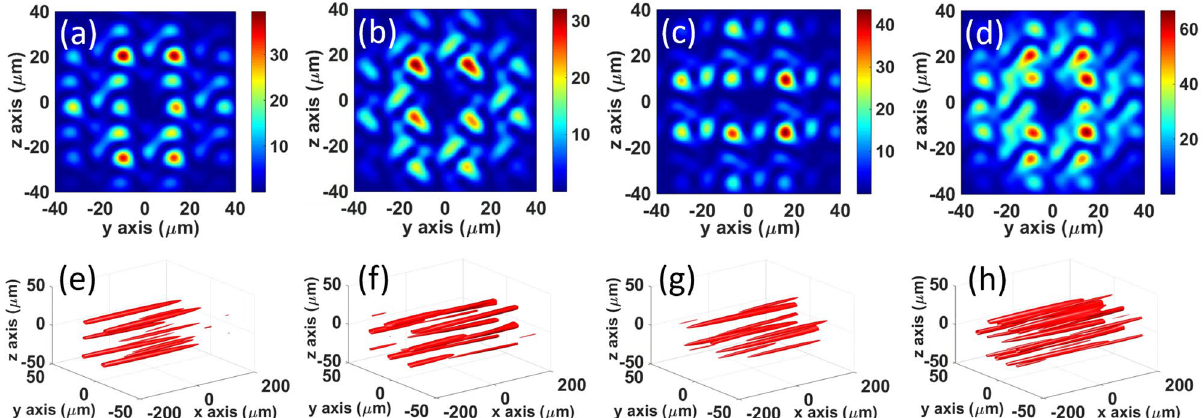
Figure 5. ( a )–( c ) Intensity distribution of the combined field at the waist plane with different random phases. ( e )–( g ) Isosurface distribution corresponding to ( a )–( c ) within the Rayleigh distance filtered with the isosurface value I max · 0.5 . I max , which is the peak intensity of the combined field in ( a )–( c ). ( d ), ( h ) Additive intensity distribution and isosurface of the above three random results. See Supplementary Fig. S2a–d for the phase diagram of ( a – d ),